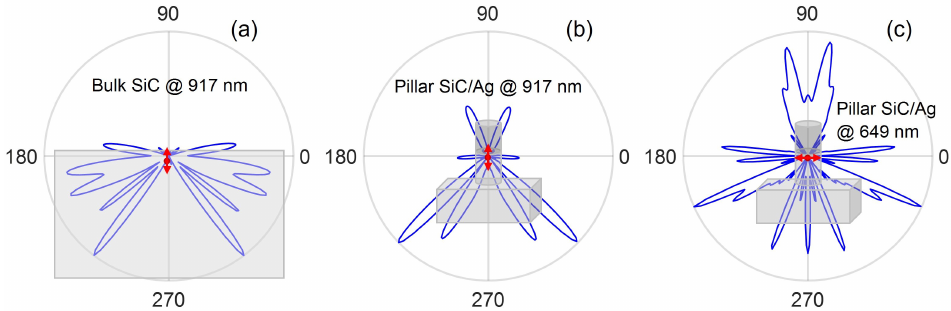
Figure 7. Far-field 2-D radiation patterns for a point dipole emission in ( a ) bulk SiC at 917 nm and SiC pillar at ( b ) 917 nm and ( c ) 649 nm,